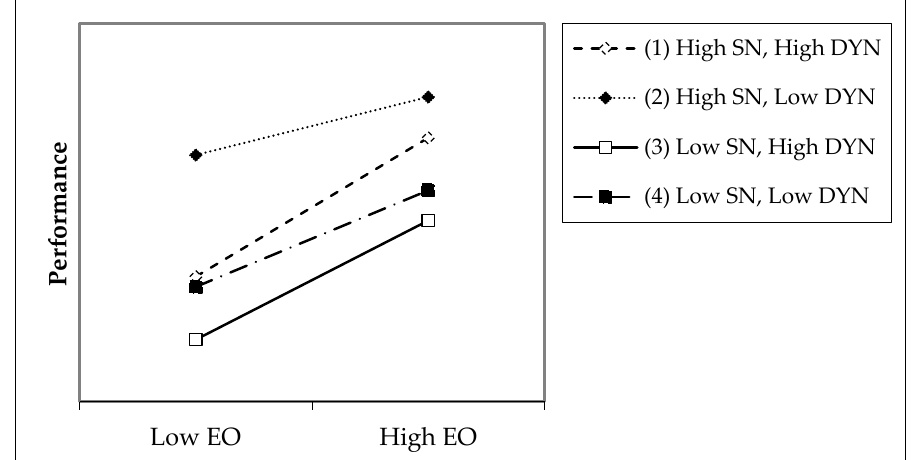
Figure 1. Entrepreneurial orientation x Strategic networking x Environmental dynamism.